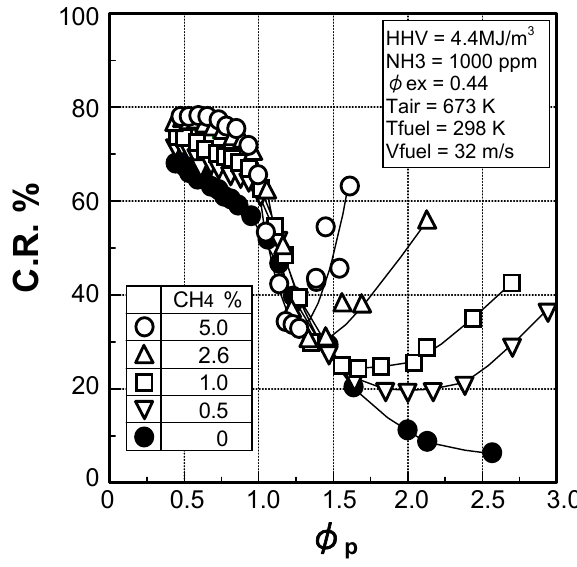
Figure 17. Influence of CH two-stage